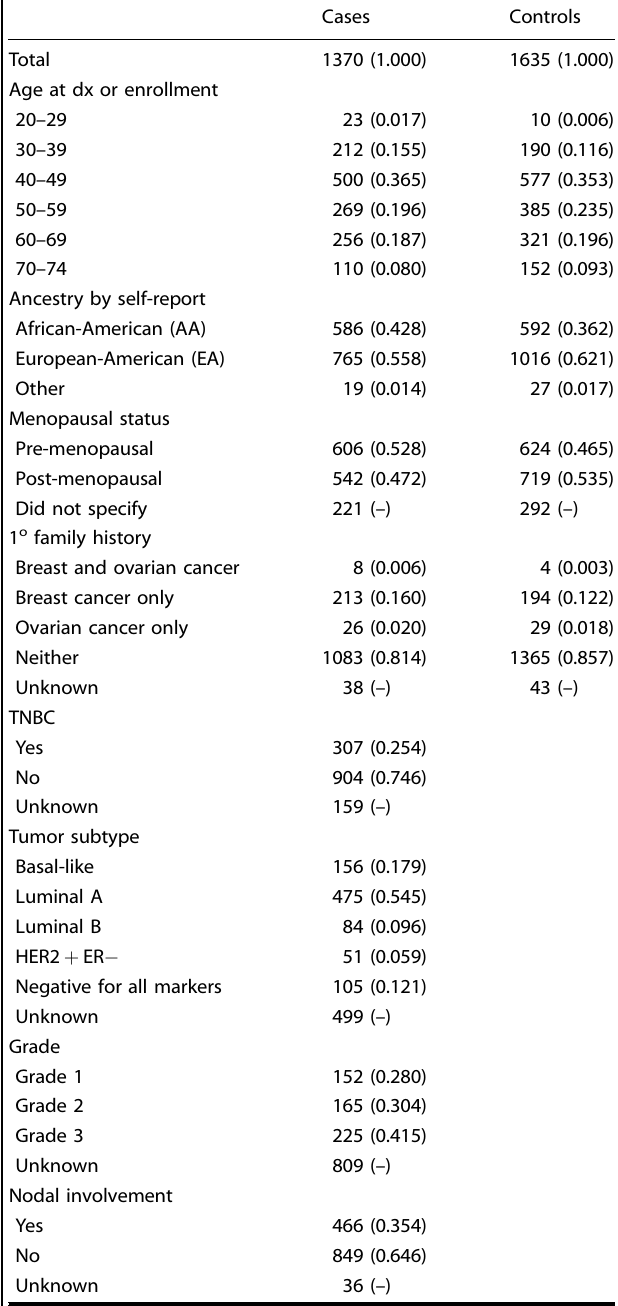
a In parentheses, proportions of participants with